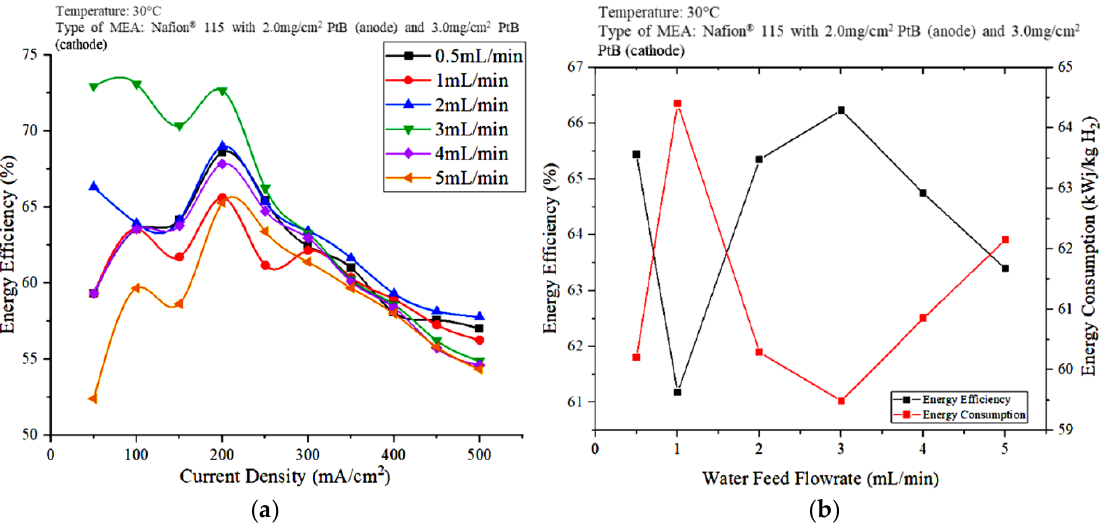
Figure 6. Effects of water flowrate on PEM electrolyzer performance ( a ) energy efficiency versus current density ( b ) energy efficiency versus water flow rate